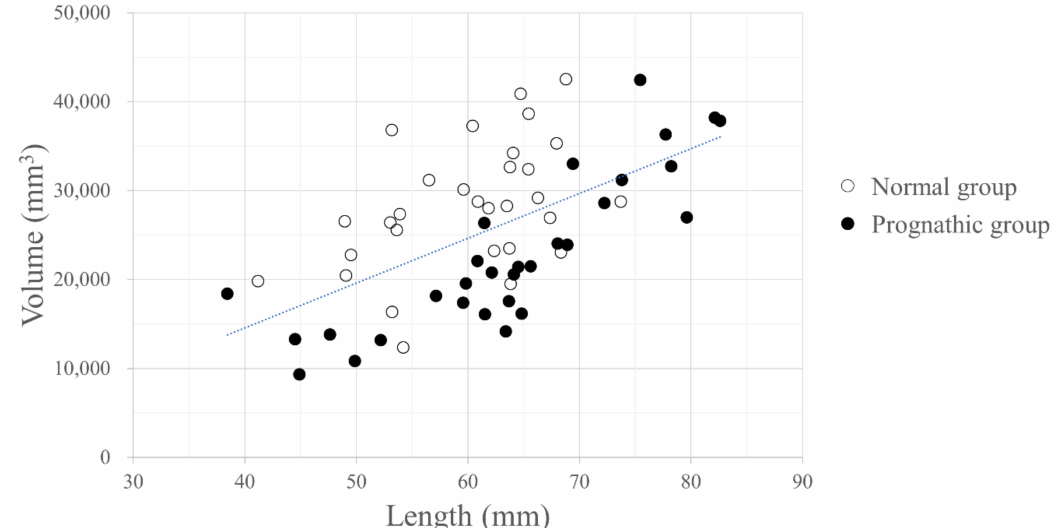
Figure 4. The distribution of masseter muscle volume/length ratios of the normal group and prognathic group. The normal group is dotted in white and the prognathic group is dotted in black. The blue dotted line indicates the trend line. Participants of the normal group are mostly distributed over the trend line, while those of the prognathic group are mostly distributed under the trend